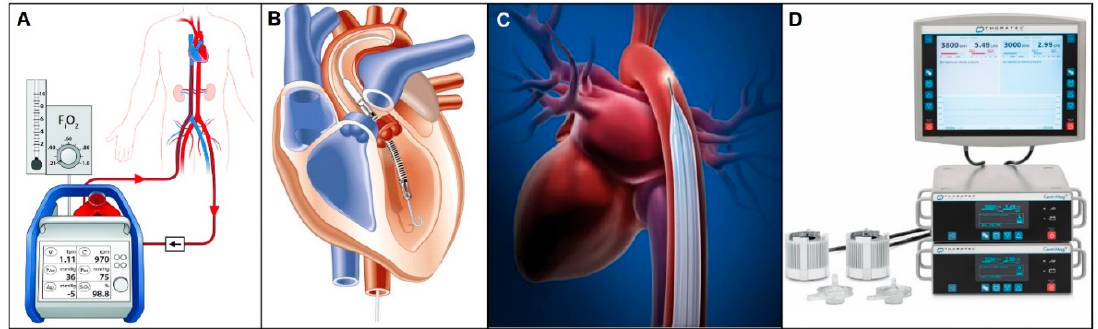
Figure 4. ECMO ( A ), AbioMed Impella ( B ), Teleflex Arrow IABP ( C ), and Thoratec CentriMag ( D )